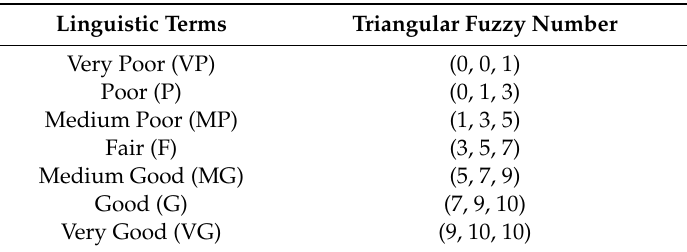
Table 2. Linguistic scale for the